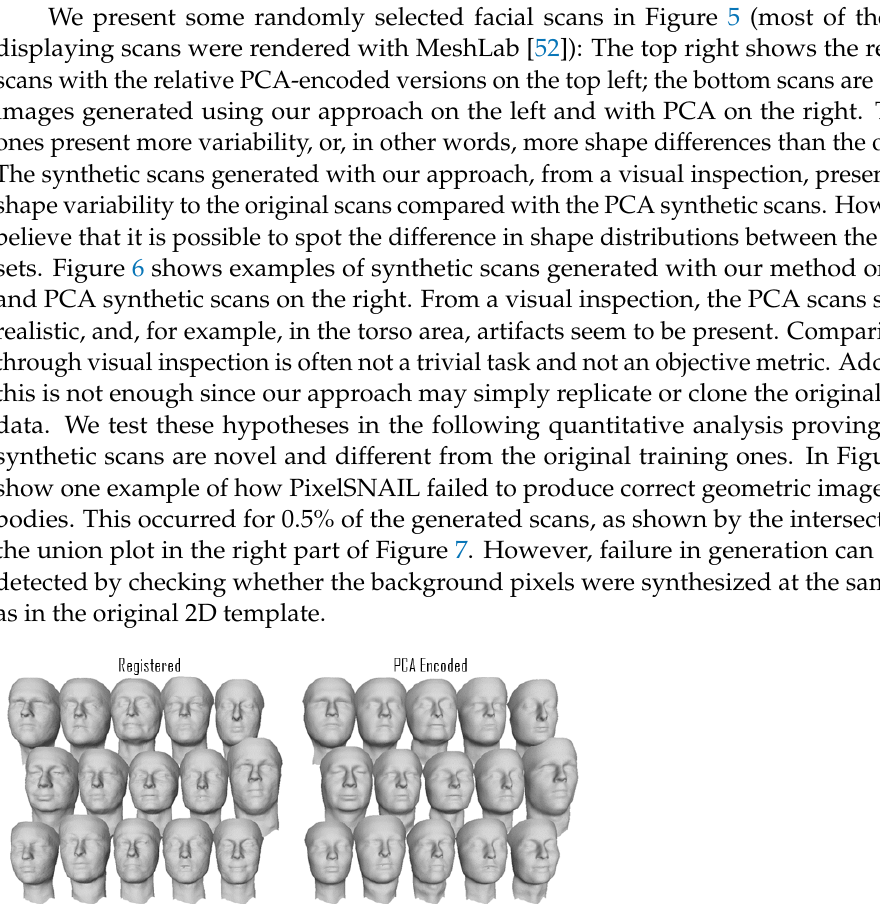
Figure 6. Example of full ‐ body scans. The three columns on the left are sampled using our approach, and the three columns on the right are samples generated using the PCA ‐ based approach. Subjec ‐ tively, our approach provides realistic scans more often than the PCA ‐ based approach, where we observe extreme shape features and often bodies with mixed gender that are not representative of the input dataset.